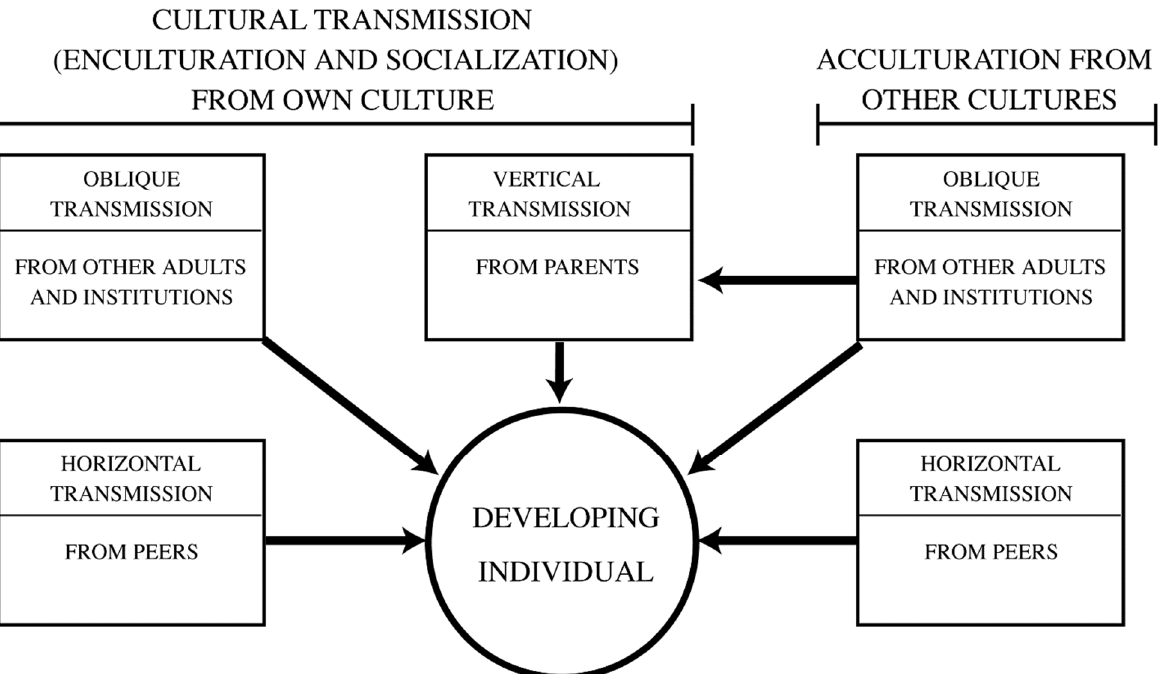
Figure 4. Framework for Examining Cultural Transmission (Enculturation and Acculturation) to Developing Individuals.